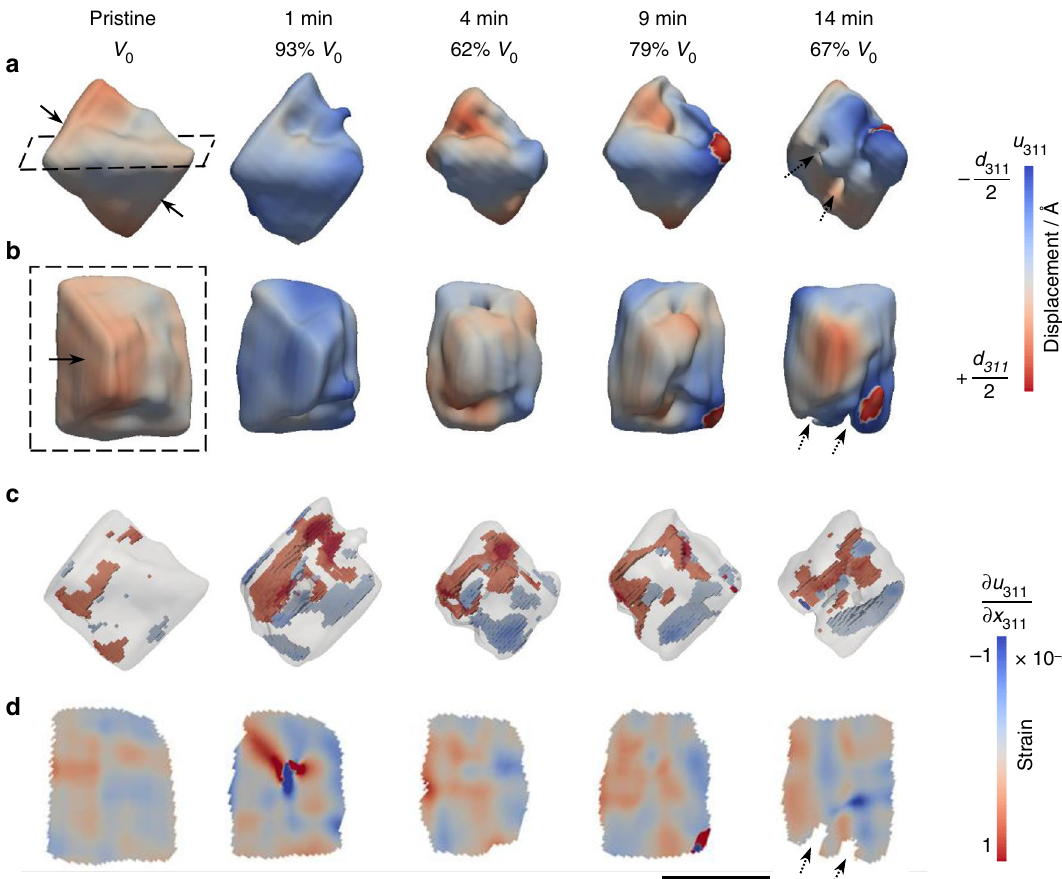
Fig. 2 Dissolution of an octahedron-shaped magnetite observed ex situ after reaction in 0.1 M HCl solution up to 14 min. a , b were the 3D volume viewed from two different perspectives at a 30% amplitude threshold. The displacement fi eld along the [311] direction were projected on the isosurfaces. c 3D strain associated with compressive (blue, strain< − 0.00035 shown in Fig. 3d) and tensile (red, strain > 0.00035 shown in Fig. 3d) strains. d Cross- sectional views of the internal strain fi eld at the dashed line box in a and b . Scale bar, 200